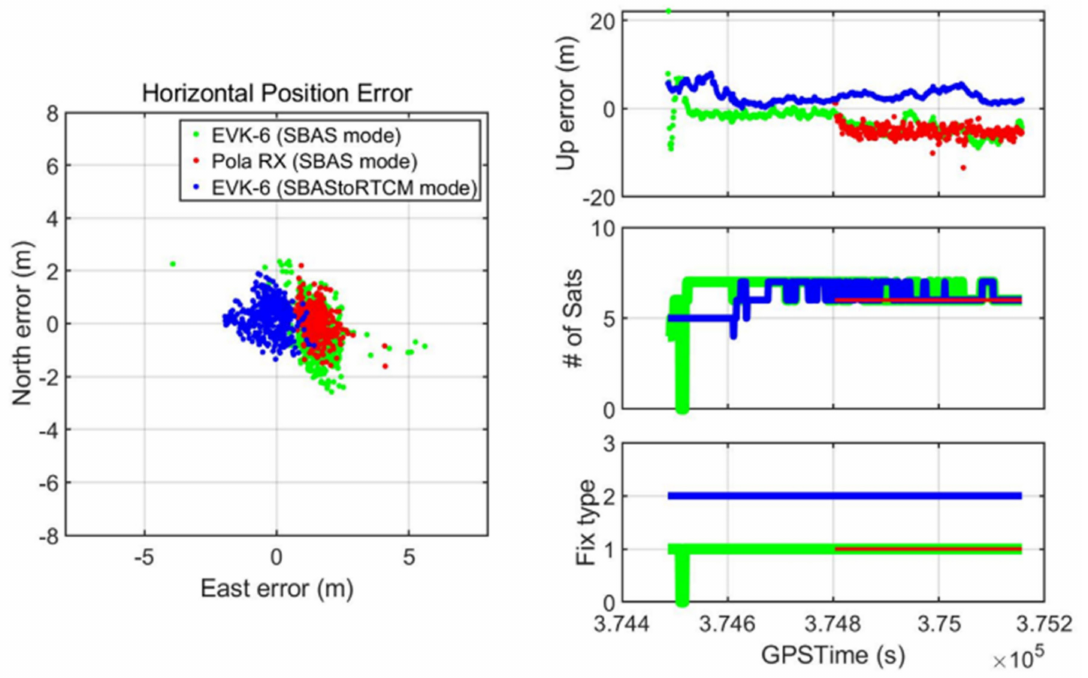
Figure 16. Dynamic test position accuracy ( left side : horizontal error, top right : vertical error, middle right : number of active satellites, bottom right : position fix